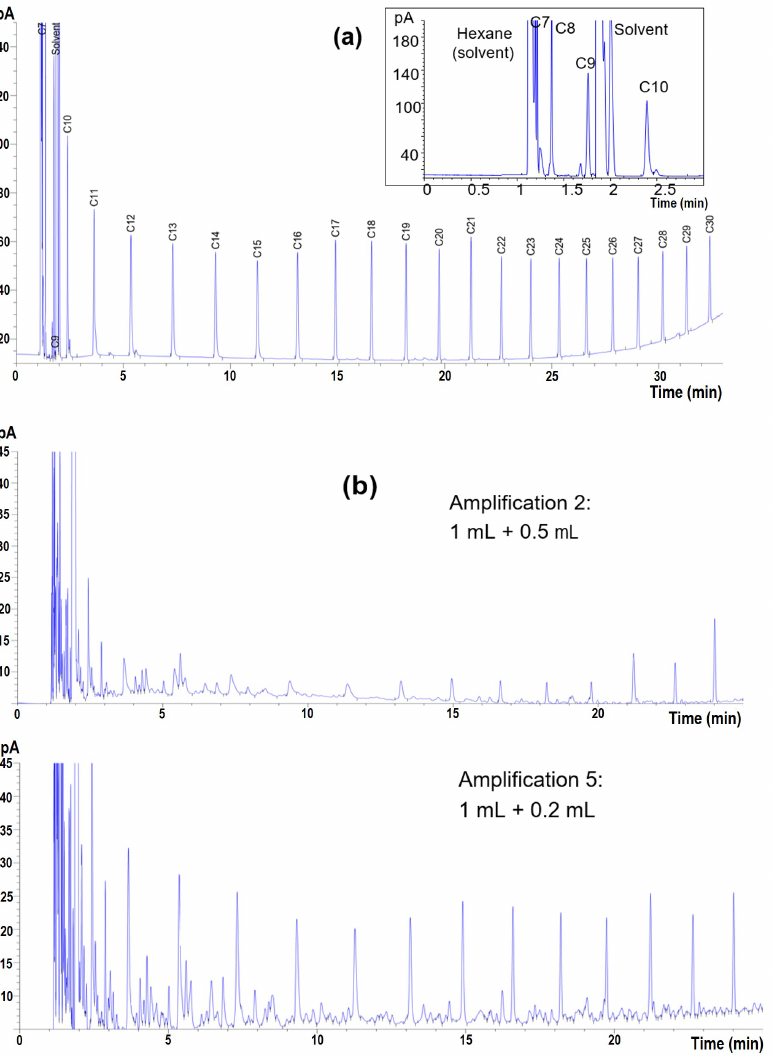
Figure 4. Calibration of C7–C30 alkanes by GC-FID using Sigma-Aldrich standard (2000 g/mL, 2 g/L diluted 1:10 in DCM) in the upper chromatogram ( a ), with retention times of C7–C10 in detail. Chromatograms showing amplification of the signal of the samples of crude oil (1% v/v, 8.6 g/L) in the lower spectra ( b ): (aqueous sample volume) + (DCM organic extractor volume).